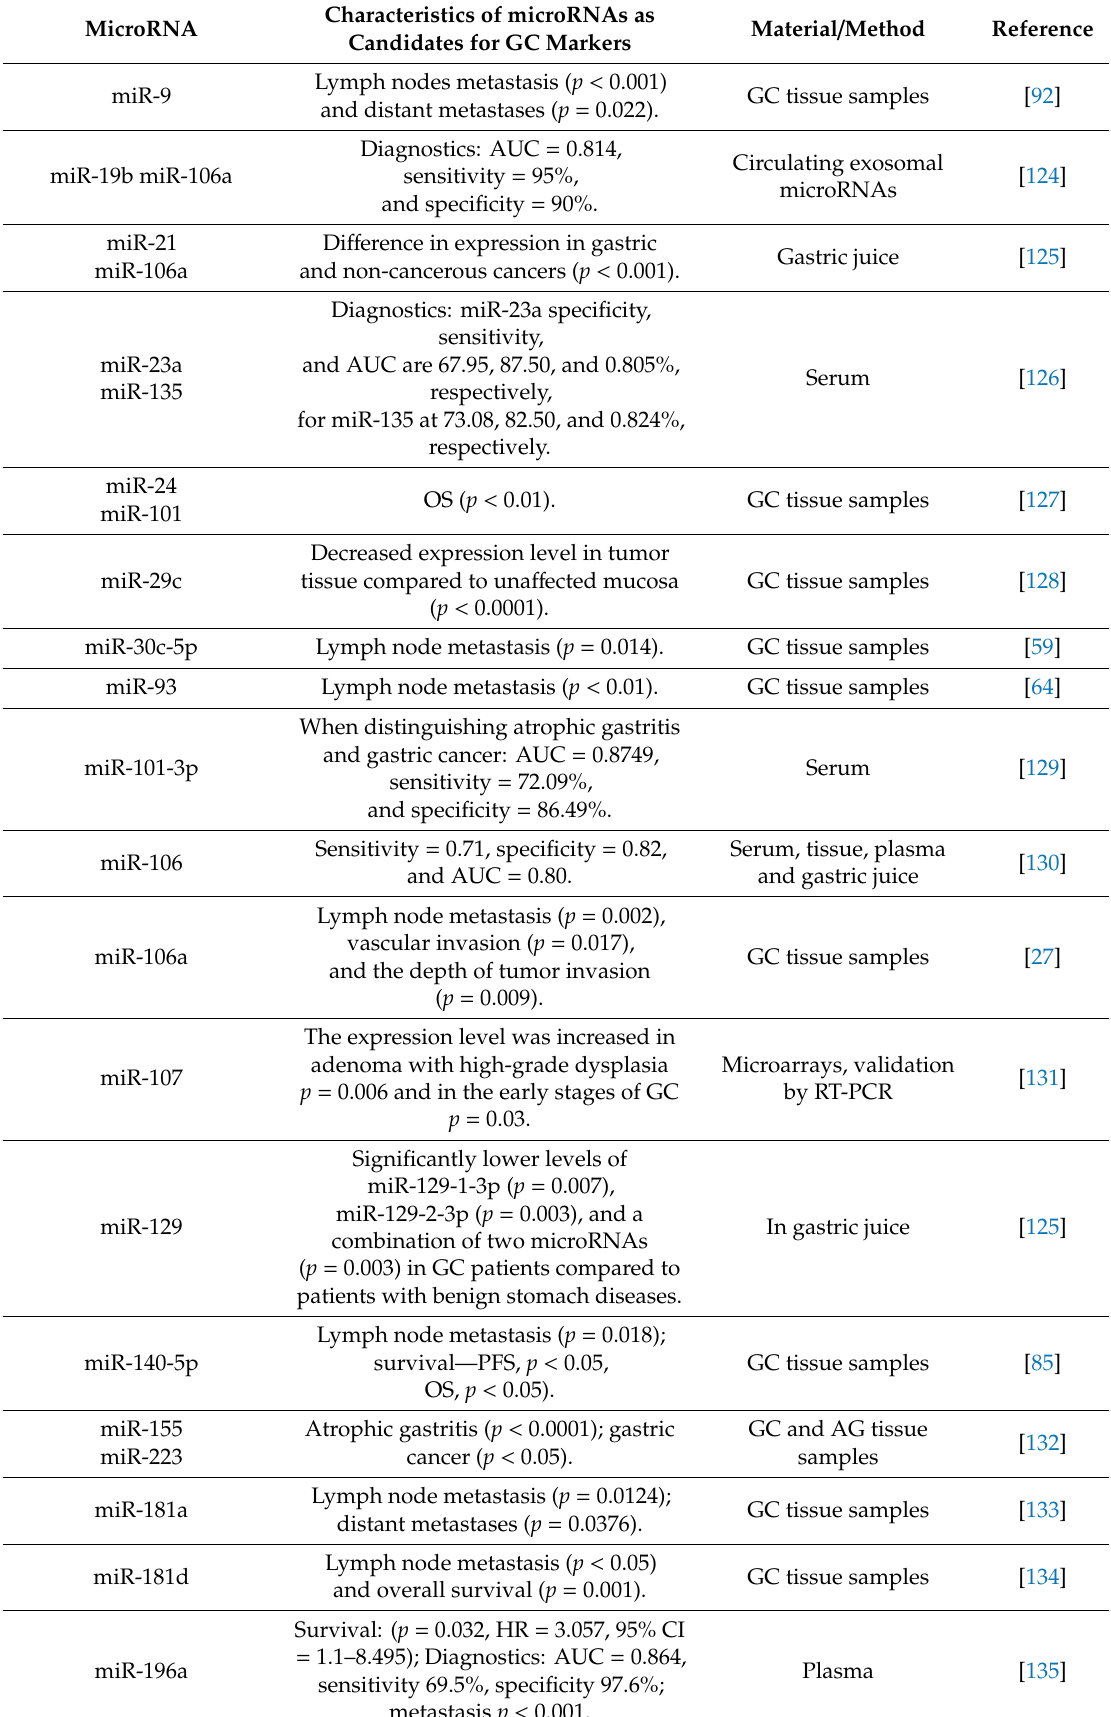
Table 3. MicroRNAs as potential GC